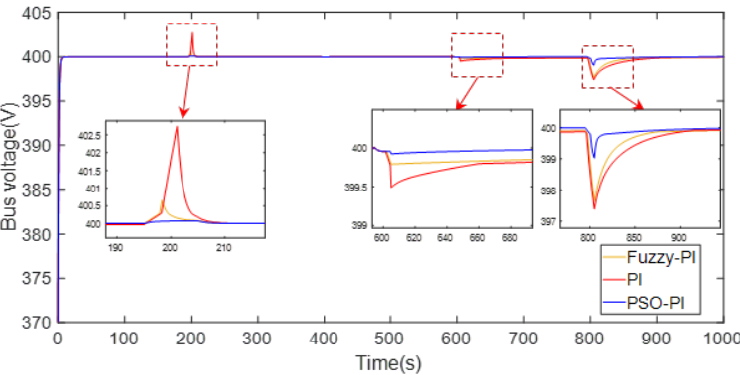
Figure 13. Bus voltage in Example 1.